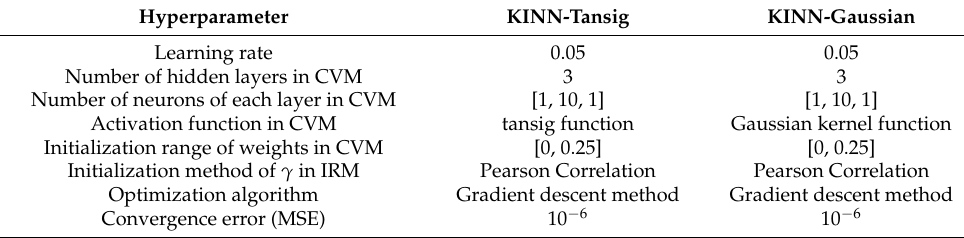
Table 1. The hyperparameters for KINN-tansig and KINN-Gaussian in three cases.